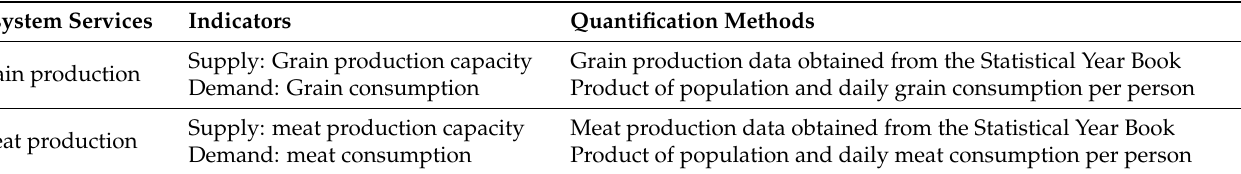
Table 1. The indicators and quantification methods of the selected